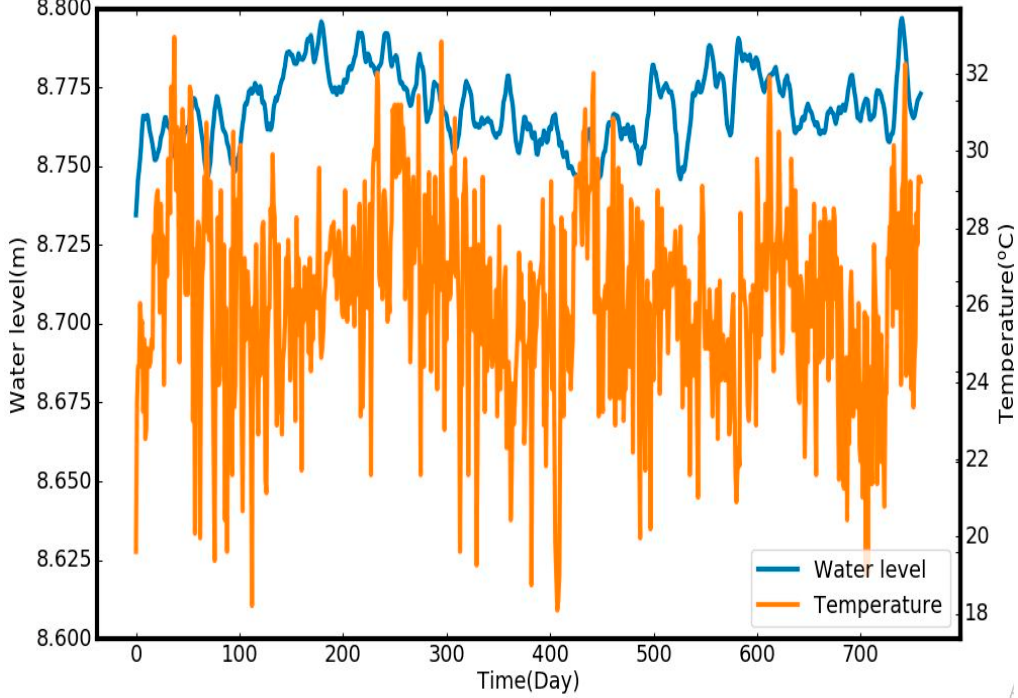
Figure 4. Time series plot of temperature and groundwater level collected from the Mukarange monitoring borehole.